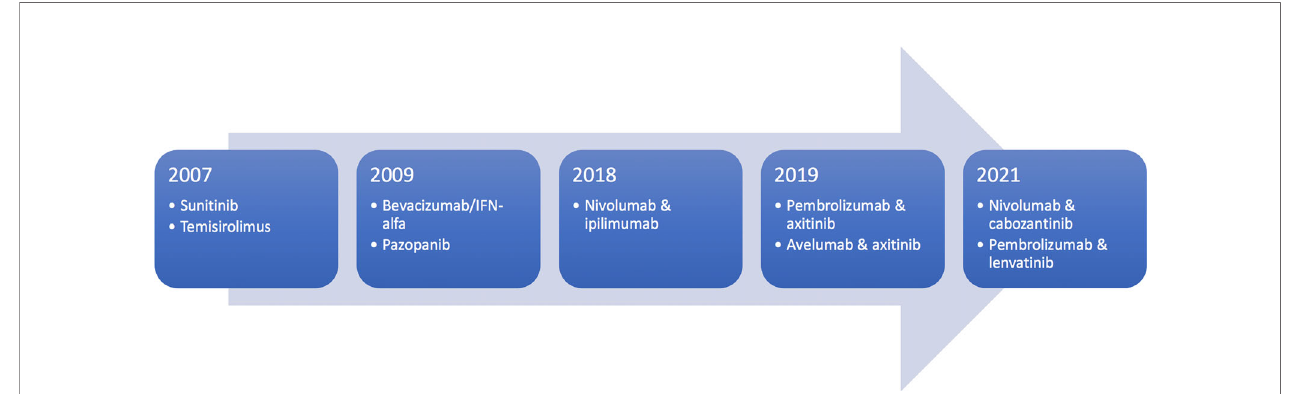
FIGURE 1 | Timeline of FDA-approved treatment for metastatic RCC in fi rst-line